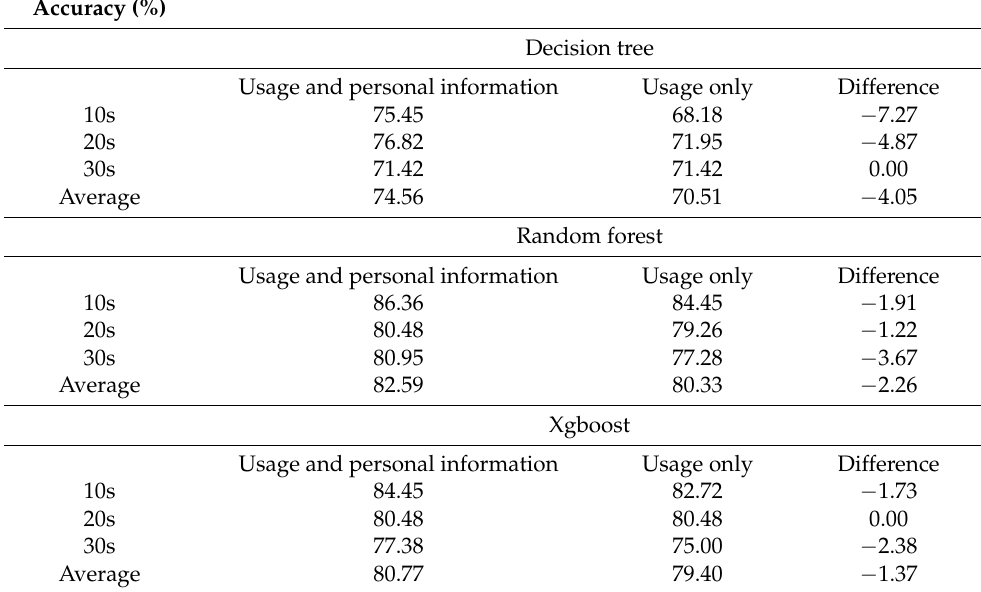
Table 7. Accuracy